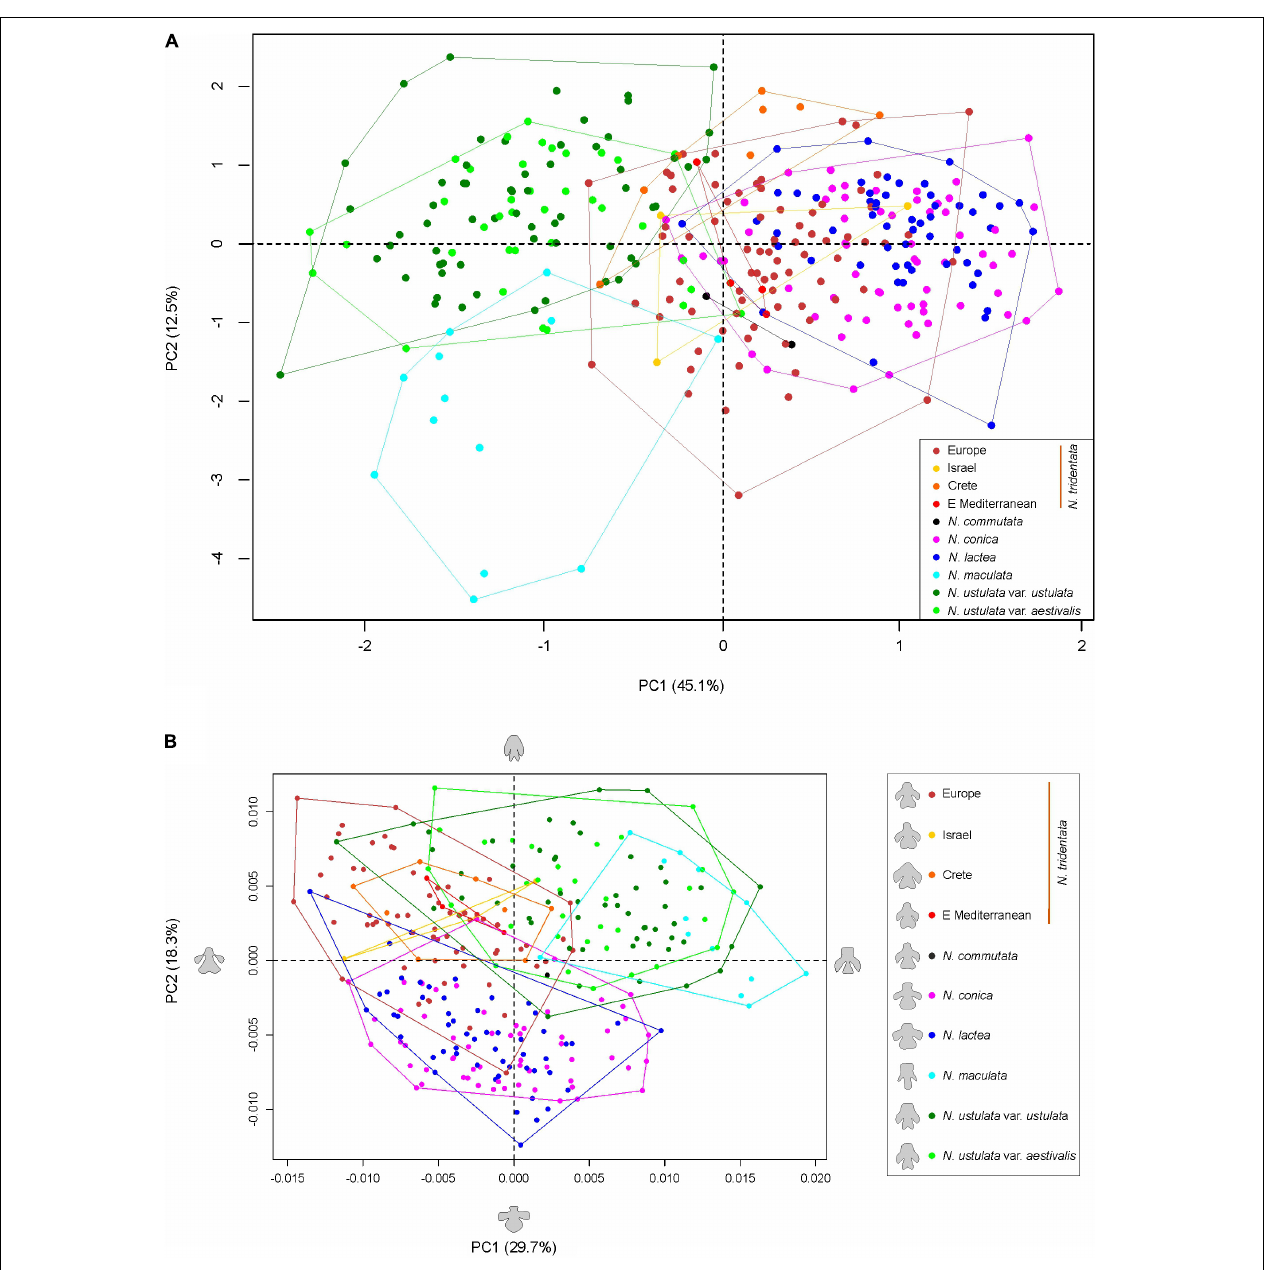
FIGURE 9 | Geometric morphometrics: principal component analysis (PCA) of (A) normalized landmarks obtained via Generalized Procrustes analysis of 325 individuals of all Neotinea taxa; (B) lip shapes determined by Fourier analysis of outlines and usage of nine harmonics of 292 individuals of all Neotinea taxa. The right-hand pane shows the averaged shape of the lip of all included taxa and the color